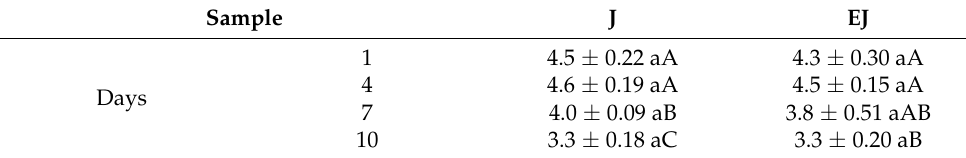
Table 5. Growth of C. jejuni (log cfu/g) in chicken burgers for 10 days of storage: with inoculum (J); with 8% of spray-dried extract and inoculum (EJ). Sample